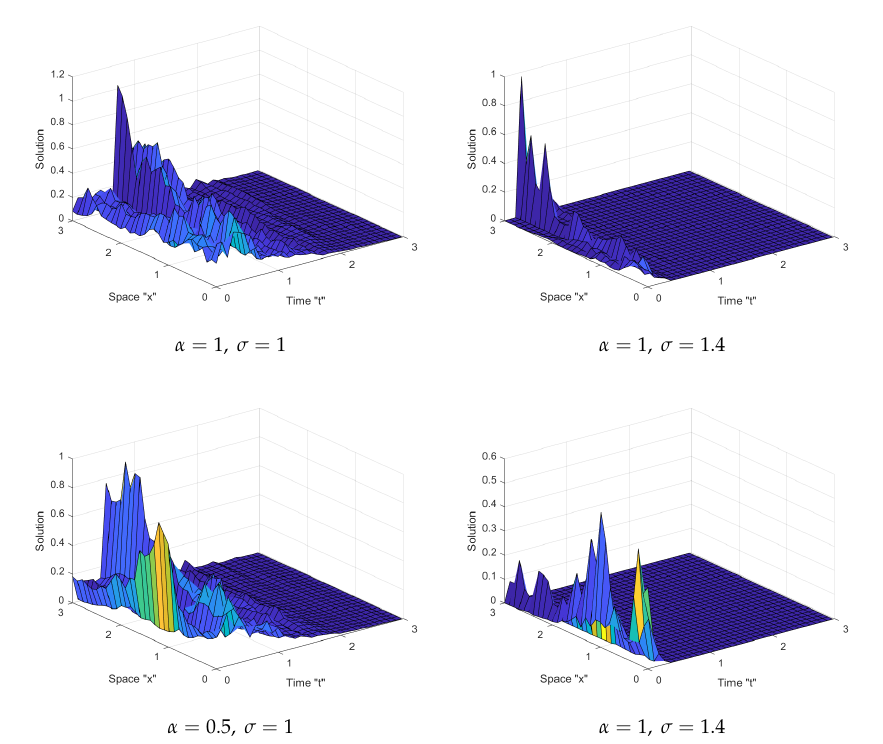
Figure 2. 3D shapes of the solution (14) for σ = 1,2 and α = 0.5,1.